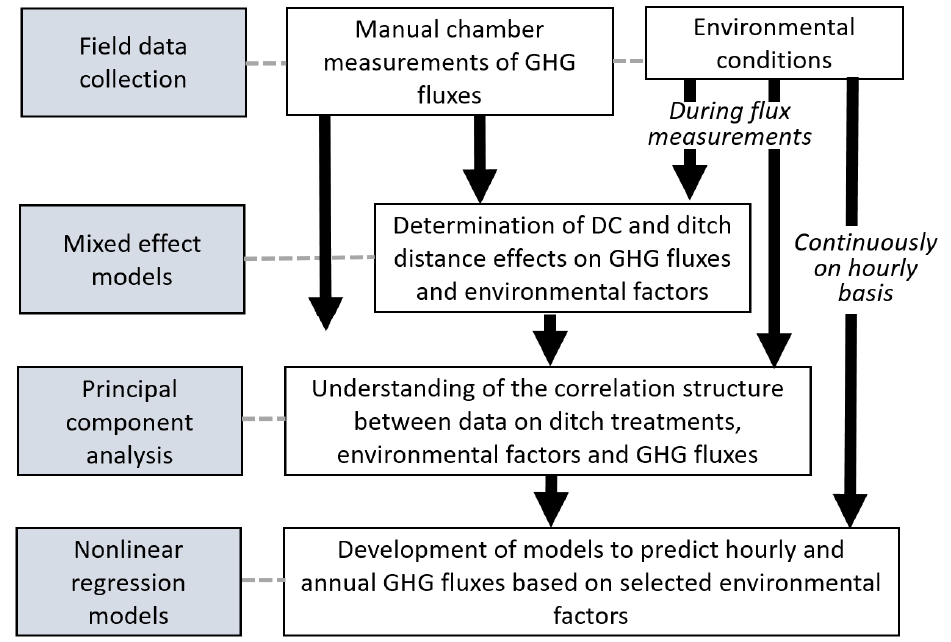
Figure 2. Flowchart of study methodology.